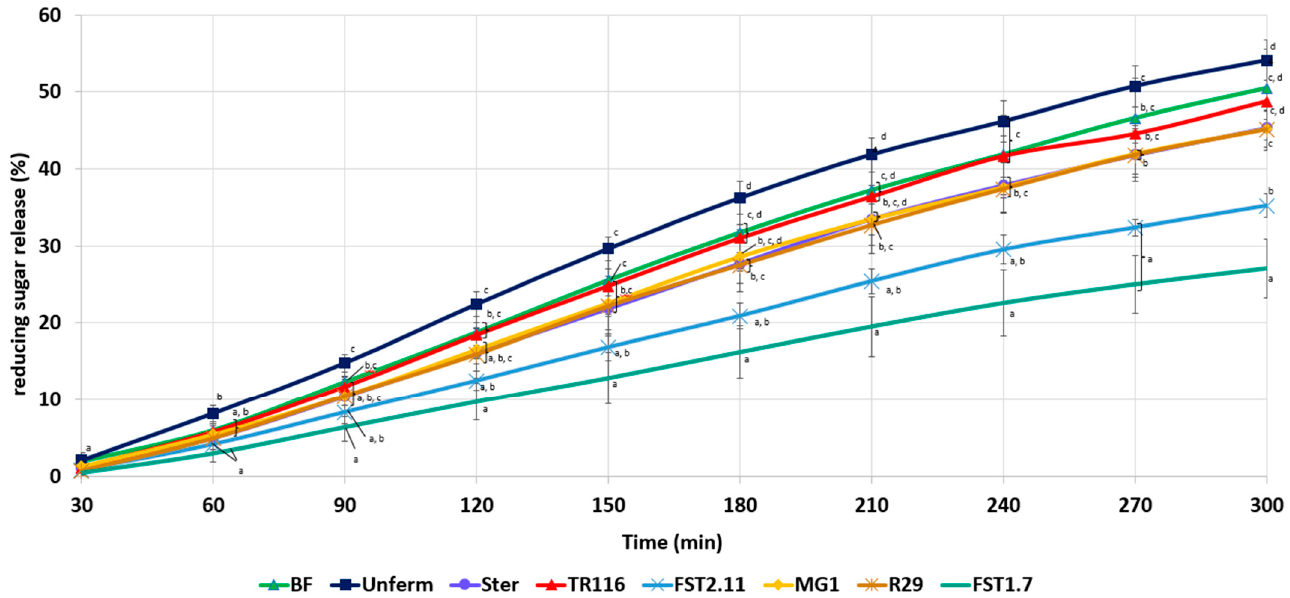
Figure 4. Release of reducing sugars during the in vitro starch hydrolysis of BR breads. BF, UnFerm, and Ster represent control recipes made using baker’s flour and 5% supplementation with unfermented and sterile rootlets, respectively. TR116, FST2.11, MG1, FST1.7, and R29 represent the recipes with 5% replacement of fermented rootlets made using Leuconostoc citreum TR116, Lactobacillus amylovorus FST2.11, Weissella cibaria MG1, Lactiplantibacillus plantarum FST1.7, and Limosilactobacillus reuteri R29, respectively. The graph illustrates the mean values of triplicate samples with standard deviations represented by error bars. Graph points that share the same letter at each time point do not differ significantly. Table 7. Descriptive sensory analysis of BR breads. BF represents results obtained from bakers’ wheat flour breads. BR-UnF and BR-Ster denote control recipes made with 5% inclusion of unfermented and sterile rootlets, respectively. BR-TR116, BR-MG1, BR-FST2.11, BR-R29, and BR-FST1.7 illustrate sensory results from bread recipes made with a 5% addition of fermented rootlets produced using L. citreum TR116, W. cibaria MG1, L. amylovorus FST2.11, L. reuteri R29, and L. plantarum FST1.7 , respectively. Results are represented as mean values ± standard deviations. Values in the same row that share the same subscript letter are not significantly different ( p <